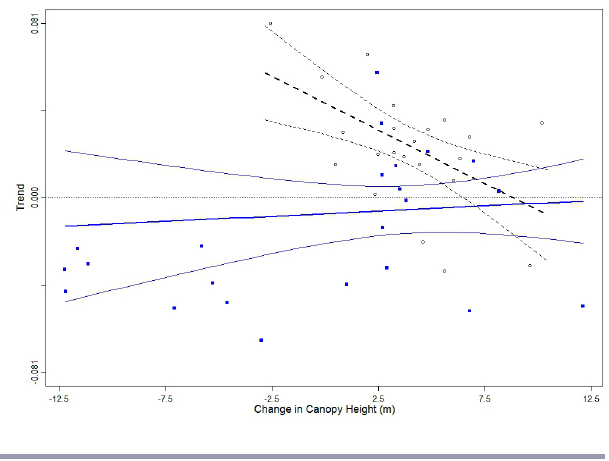
Fig. 6. Trends in Ovenbird abundance were generally negative but increased with increases in stand height in disturbed stands (blue squares and solid line, with 85% confidence intervals [dashed lines]), whereas trends in undisturbed stands were generally positive but decreased with increases in stand height (open circles and black dashed line, with 85% confidence intervals [dotted lines]) between circa 1994 and 2014. Predictions were generated using parameter estimates in Table 5 while holding proportional change in forest cover constant at the mean. Stands were considered disturbed if we noted the presence of any disturbance (e.g., fire, forest harvest, or windthrow) in the stand.